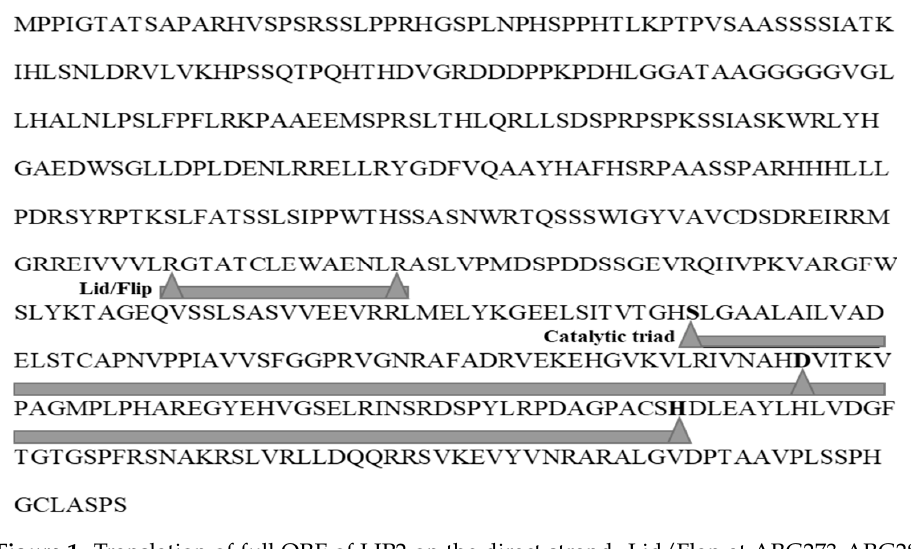
Figure 1. Translation of full ORF of LIP2 on the direct strand. Lid/Flap at ARG273-ARG286 and catalytic triad at SER355-HIS458-ASP413.